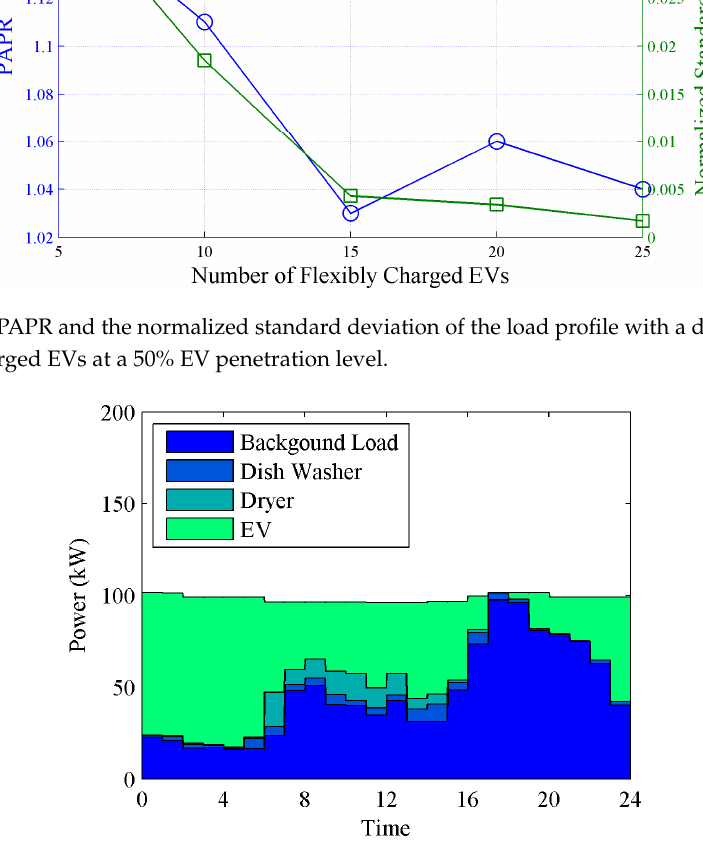
Figure 7. Aggregated load profile (15 EVs have extended charging time).